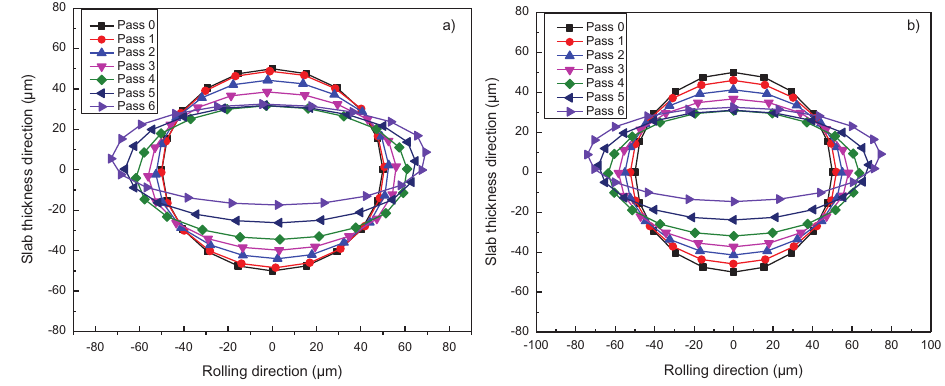
Figure 6: The plastic defor- mation of inclusions with different rolling number: a) hard inclusion; b) soft